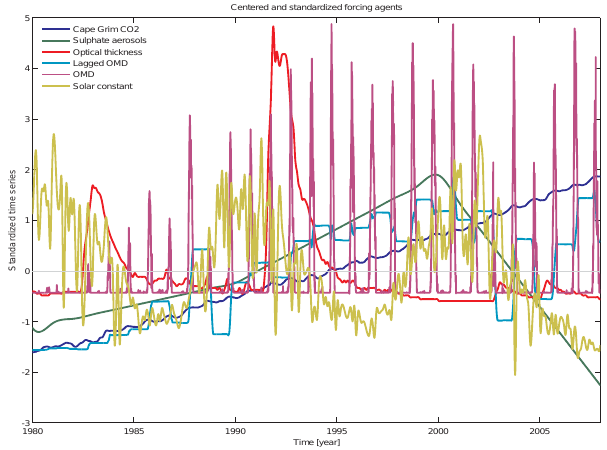
Figure 1. Forcing time series: Cape Grim CO 2 (dark blue), sul- fate aerosols (green), stratospheric aerosol optical thickness (red), lagged OMD (blue), OMD (magenta) and solar constant (khaki). Time series are normalized by subtracting the respective mean and dividing by the respective standard